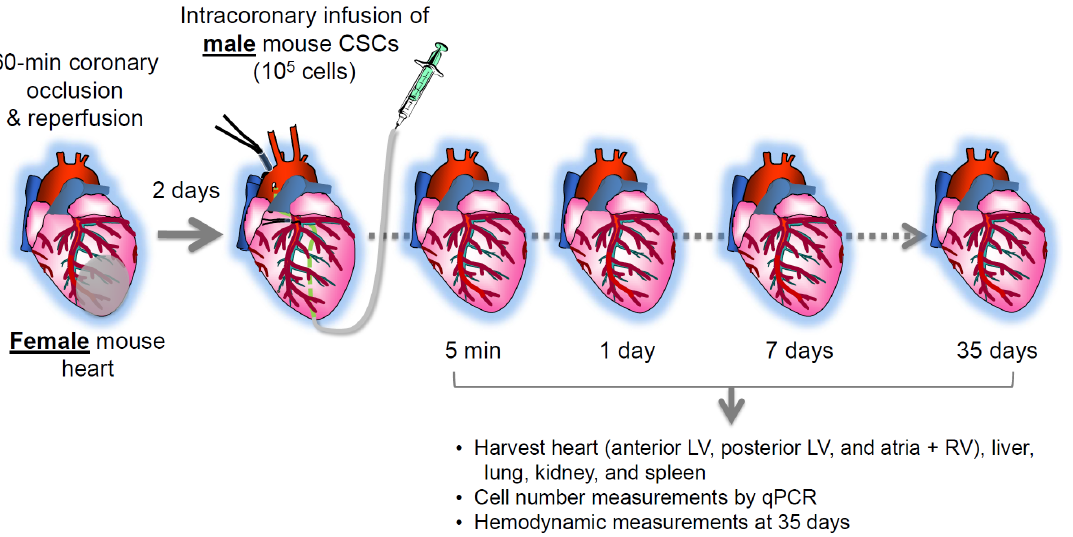
Figure 1. Experimental protocol. Left anterior coronary artery occlusion (60 min) followed by reperfusion was produced in female mice; two days later, mice received 10 5 male murine CSCs (or PBS only) via intracoronary delivery. Heart, liver, lung, kidney, and spleen were collected at indicated time points. Each tissue was analyzed for the presence of donor CSCs by qPCR as described in Materials and Methods. In the 35-day group, hemodynamic measurements were performed prior to euthanasia to assess cardiac function.